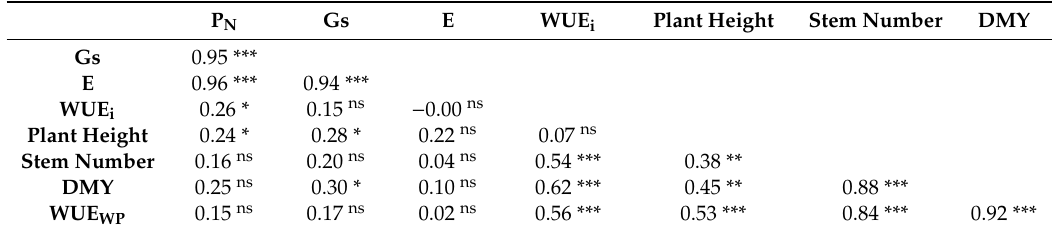
Table4. Pearson’scorrelationtestamongphysiological, morphologicalandproductivetraits.